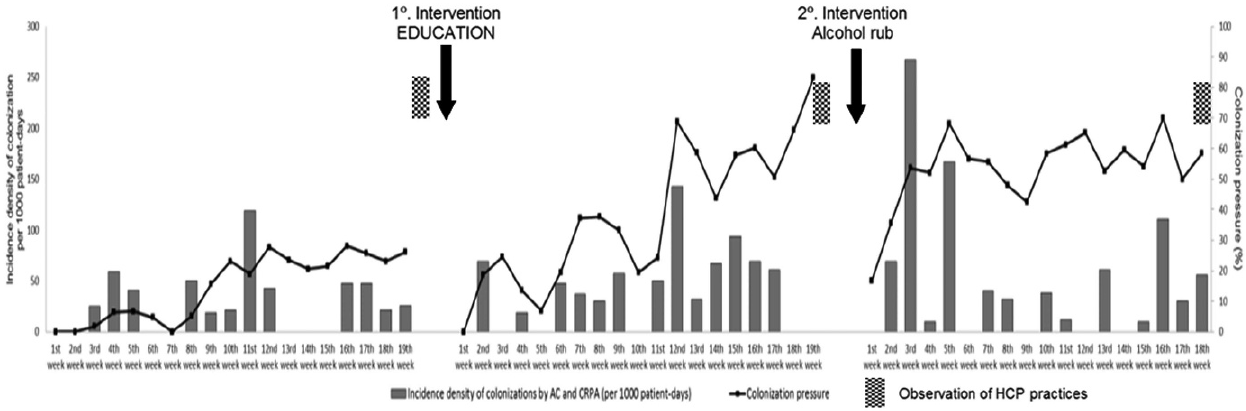
Figure 2 - Weekly colonization pressure and incidence density of multiresistant Acinetobacter spp. or carbapenem-resistant Pseudomonas aeruginosa colonization in each of the three study periods. Neurology Intensive Care Unit, Hospital das Clı´nicas